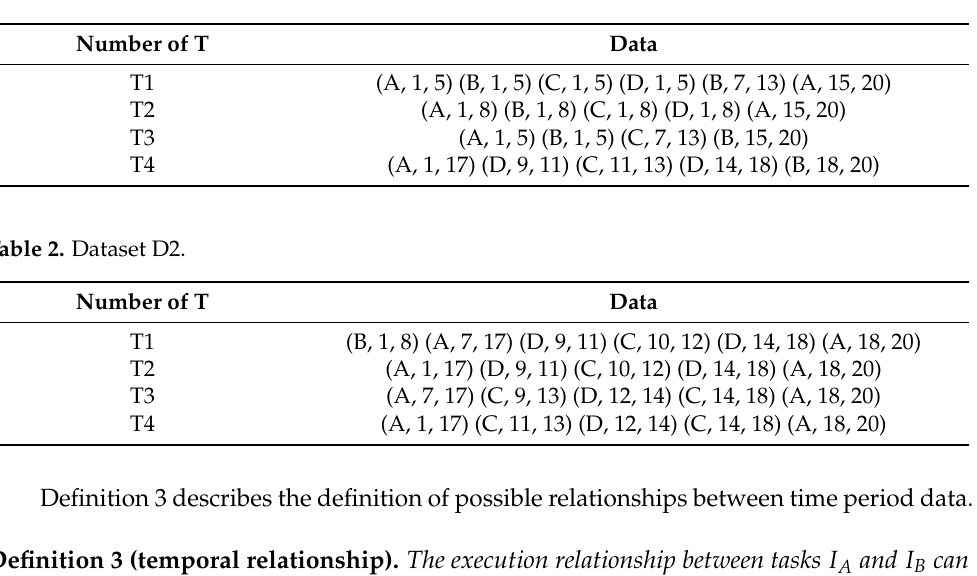
Table 1. Dataset D1.